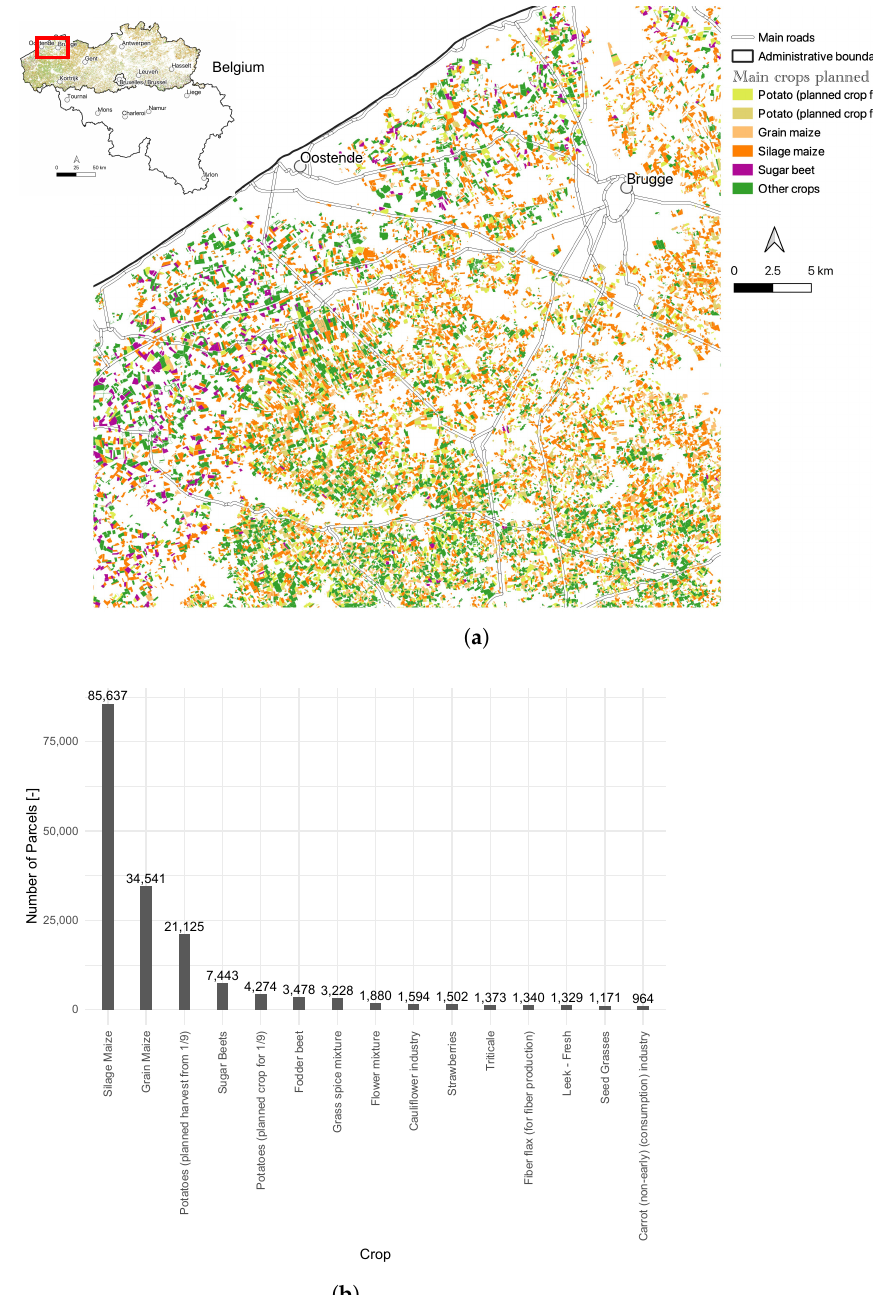
Figure 1. An overview of the selected crops in the 2020 database of Flanders, Belgium. ( a ) Agricultural parcels with potential bare soil between mid April and end of May and a close look at a subset